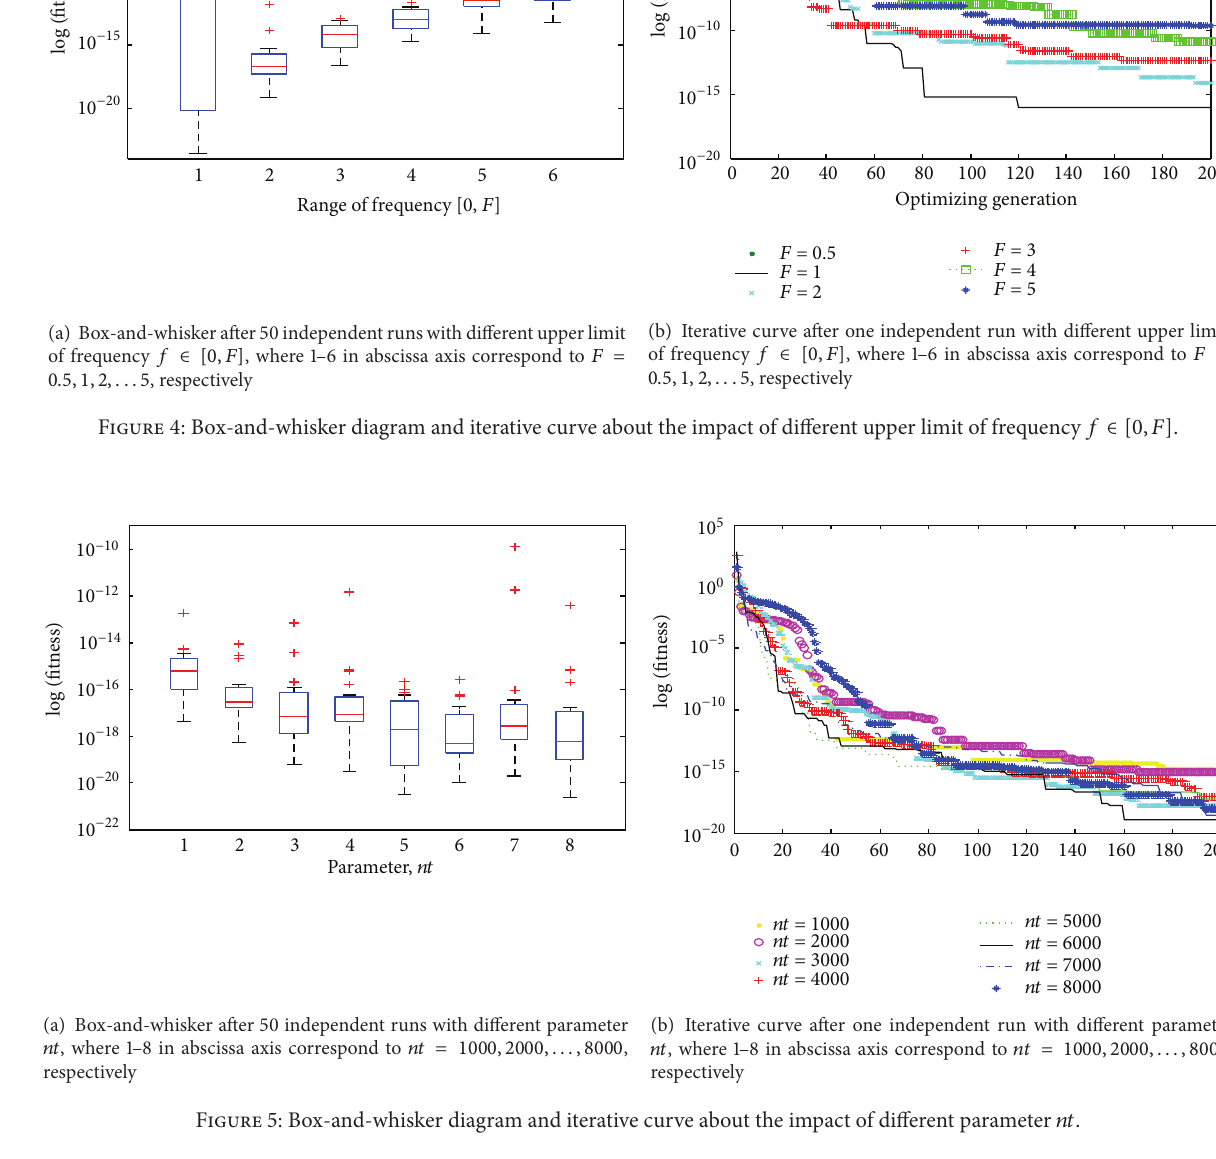
frequency range for the proposed algorithm. The